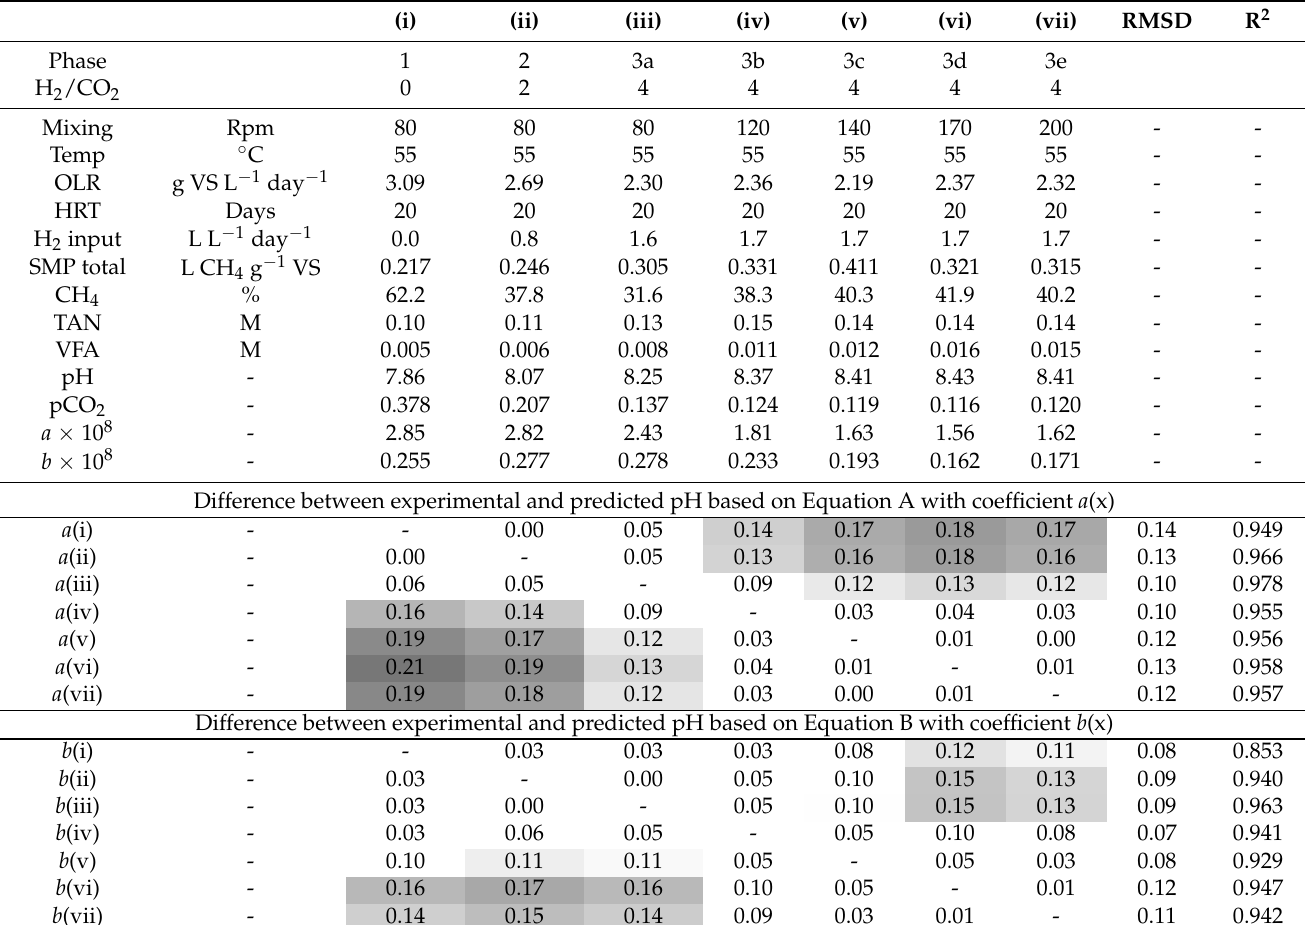
Table 2. Performance of Equations A and B for reported average values from Wahid and Horn